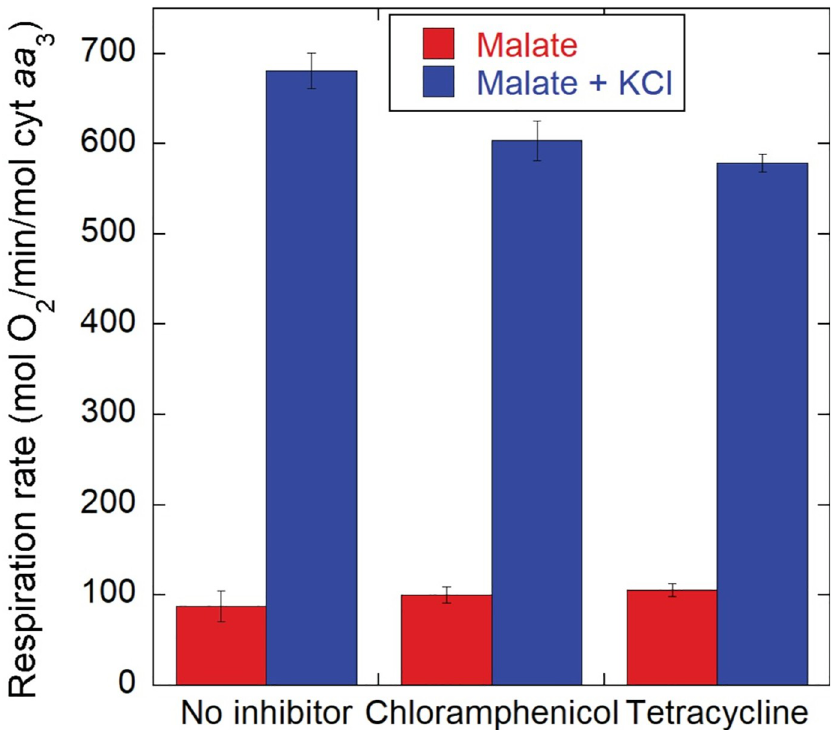
Fig 10. Effect of protein synthesis inhibitors on the activation of respiration by K + . Thawed CyoB - /CcoN - K + - depleted cells (10 9 /ml) grown on malate were incubated with either 4.2 μ l of ethanol (solvent effect control), 30 μ g/ml of chloramphenicol or 12.5 μ g/ml of tetracycline for 9 min before addition of 16.5 mM sodium malate, followed 4 min later by 5 mM KCl. The respiration rates observed during incubation with sodium malate only (red) and after KCl addition were averaged for five independent experiments for each condition. Error bars correspond to S.E. The slight inhibition of the K + activated respiration by chloramphenicol (11%) and tetracycline (15%) relative to the no inhibitor condition was statistically significant (p < 0.05;